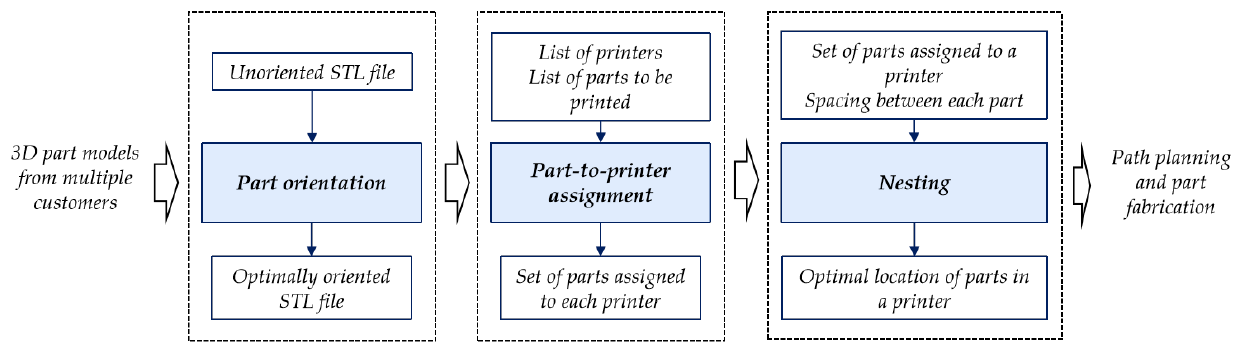
Figure 2. The framework of the proposed approach.